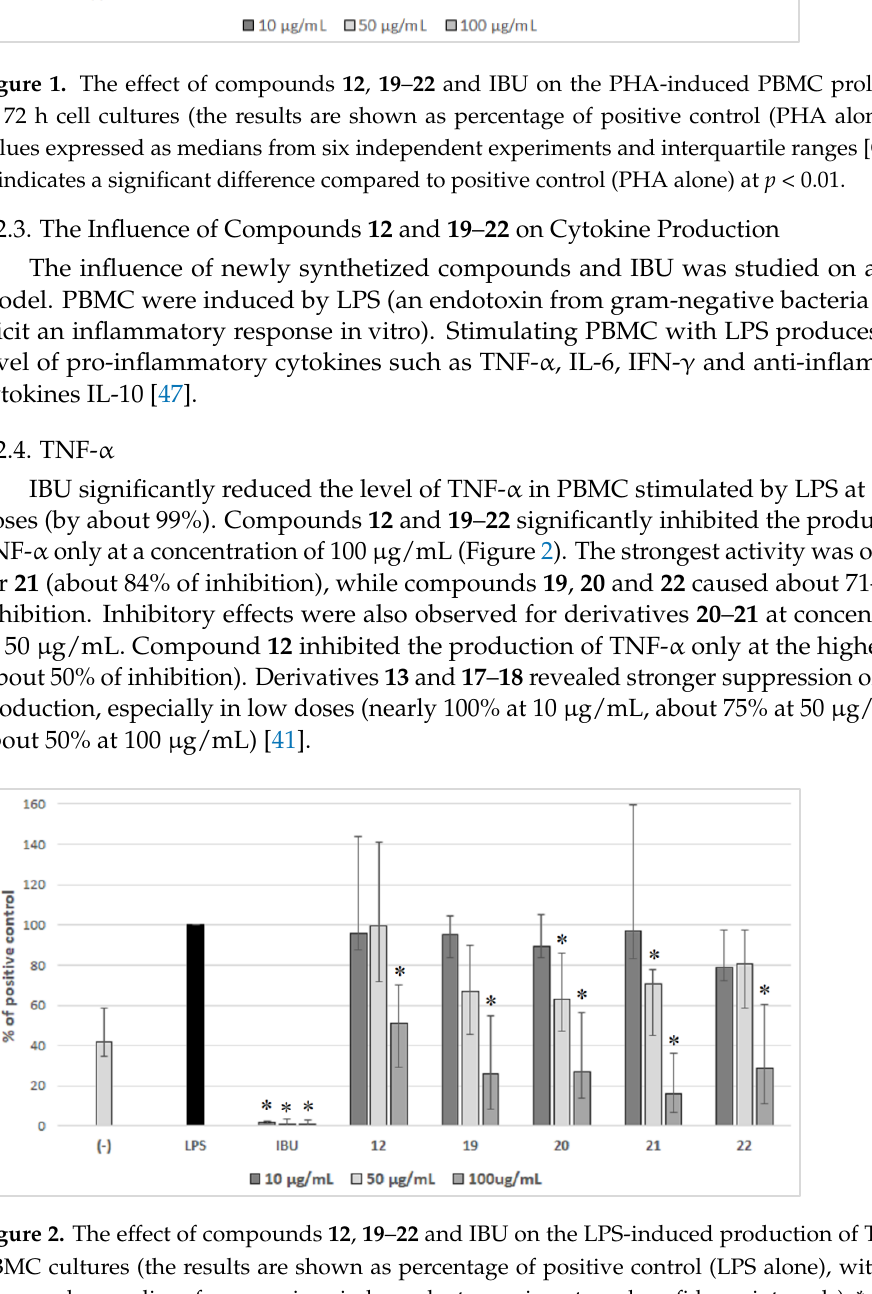
Figure 2. The effect of compounds 12 , 19 – 22 and IBU on the LPS-induced production of TNF- α in PBMC cultures (the results are shown as percentage of positive control (LPS alone), with values expressed as medians from previous independent experiments and confidence intervals); * indicates a significant difference compared to the positive control (LPS alone) at p < 0.05.